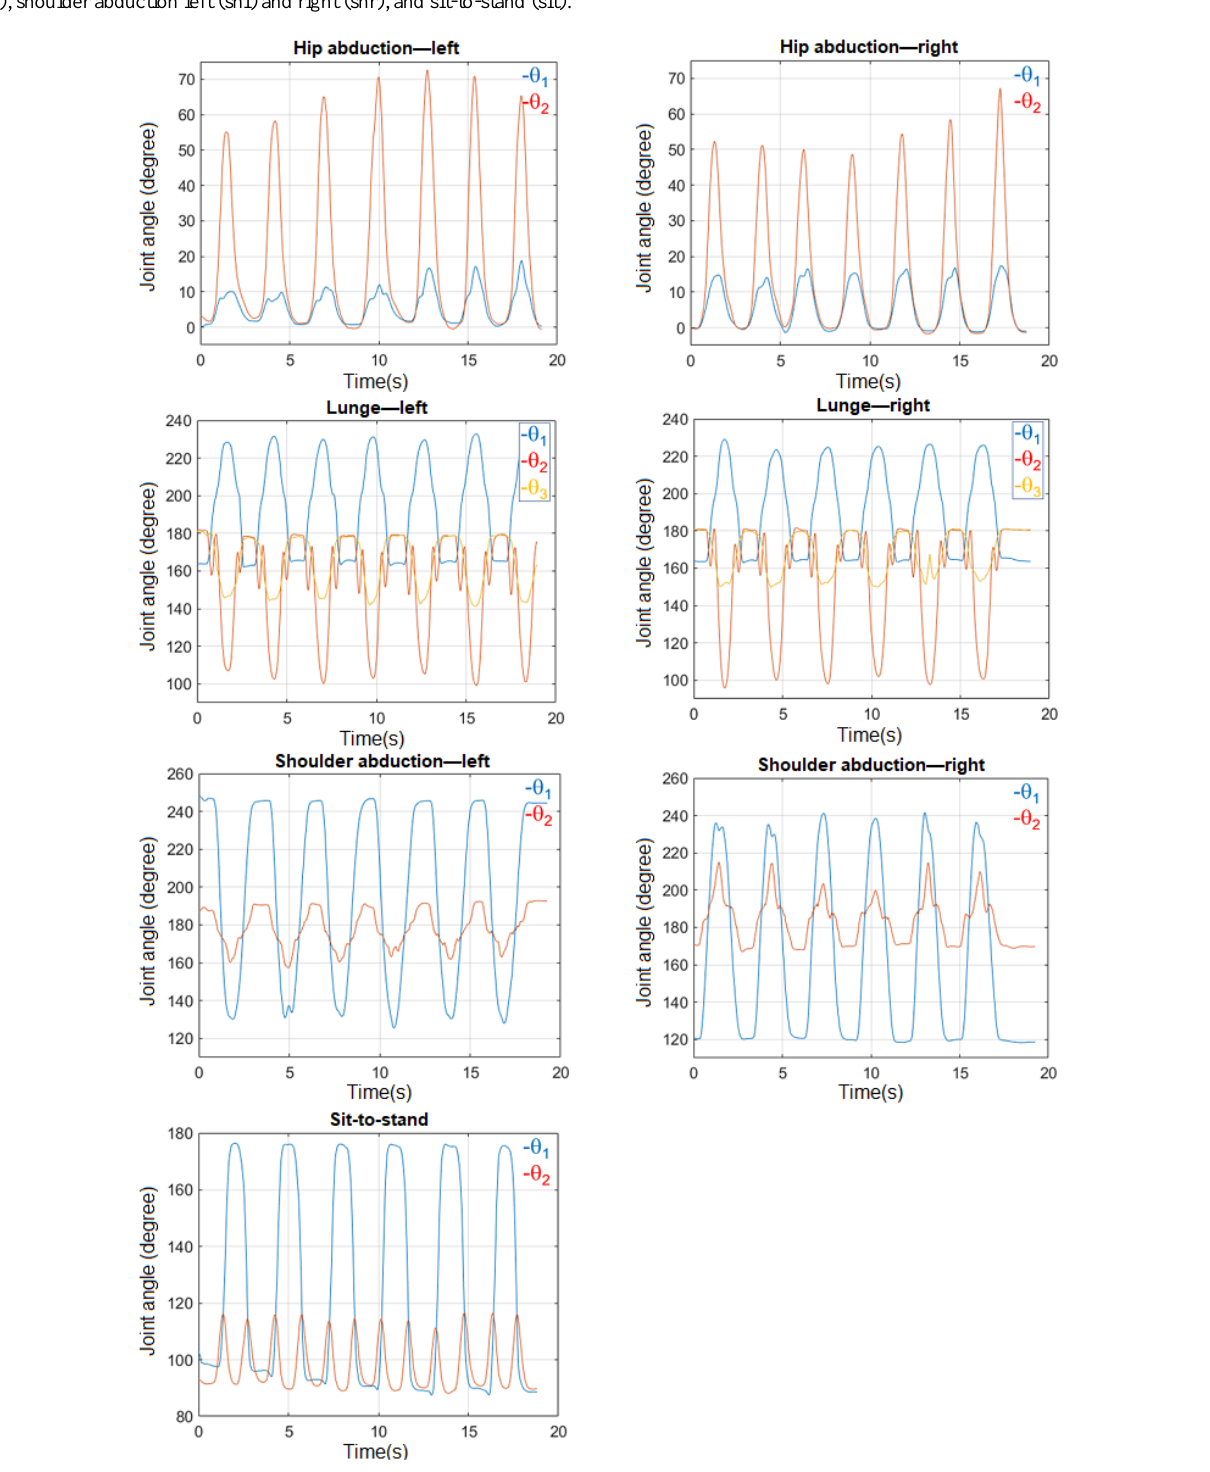
Figure 4. Sample extracted features obtained from 3D position for all seven exercises: hip abduction left (hpl) and right (hpr), lunge left (lul) and right (lur), shoulder abduction left (shl) and right (shr), and sit-to-stand